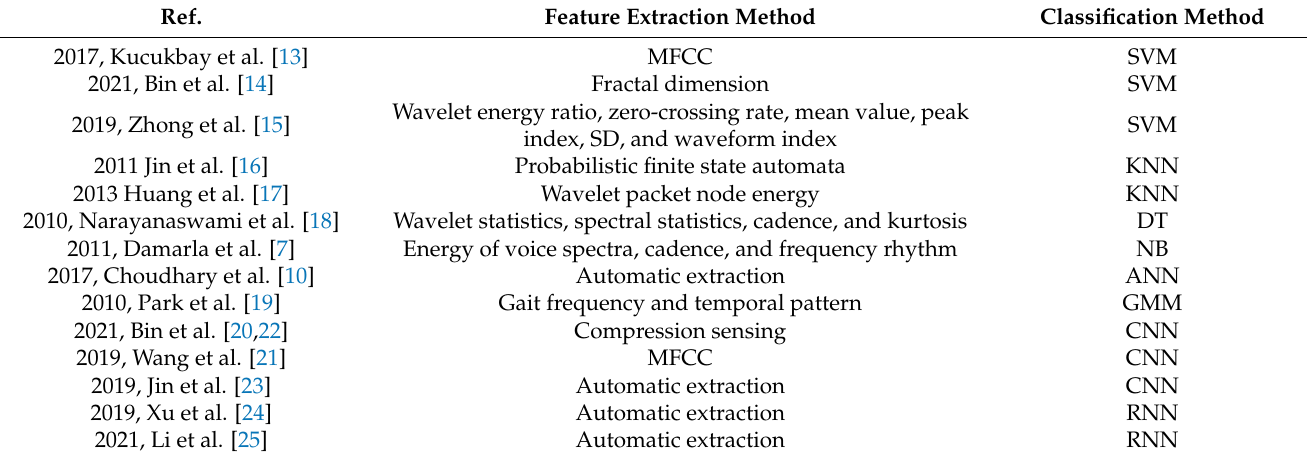
Figure 1. UGS principle of operation. Table 1. List of references on machine learning methods for moving target recognition based on sound and seismic signals. Ref.